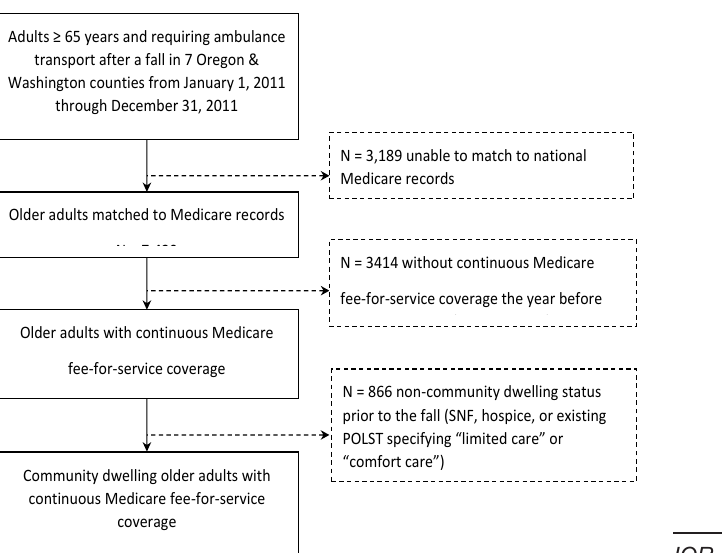
Figure 1. Schematic of cohort creation.